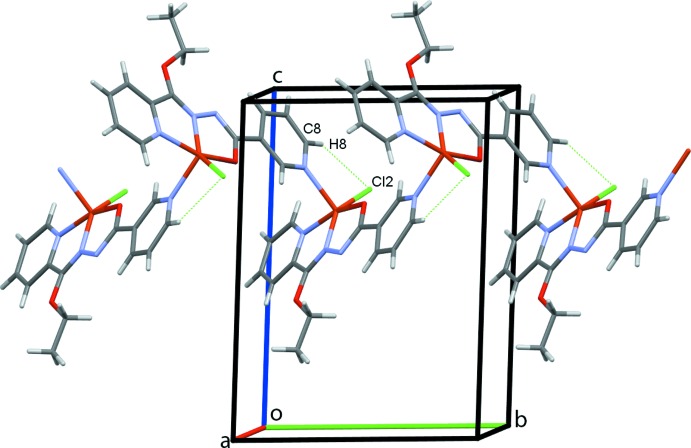
The polymer expansion of complex I, showing an infinite chain propagating along the b-axis direction. In this and subsequent figures, hydrogen bonds are drawn as dashed lines.